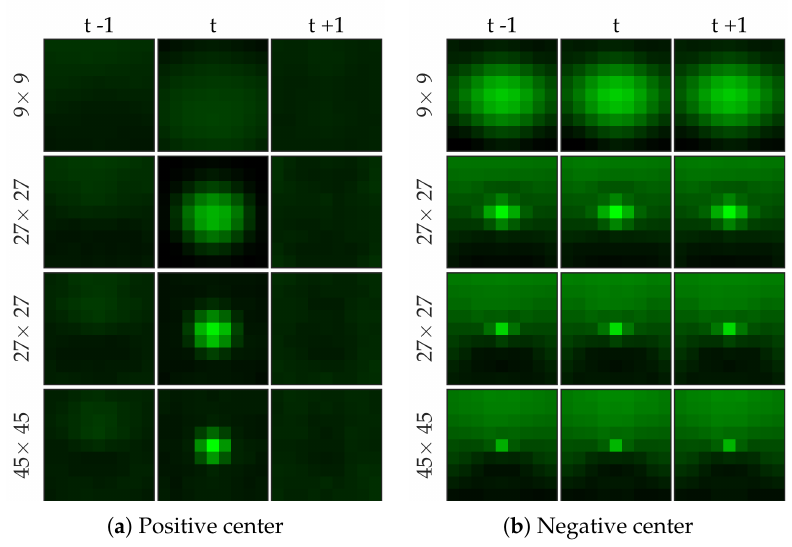
Figure 8. Examples of centers of RBF network for cell